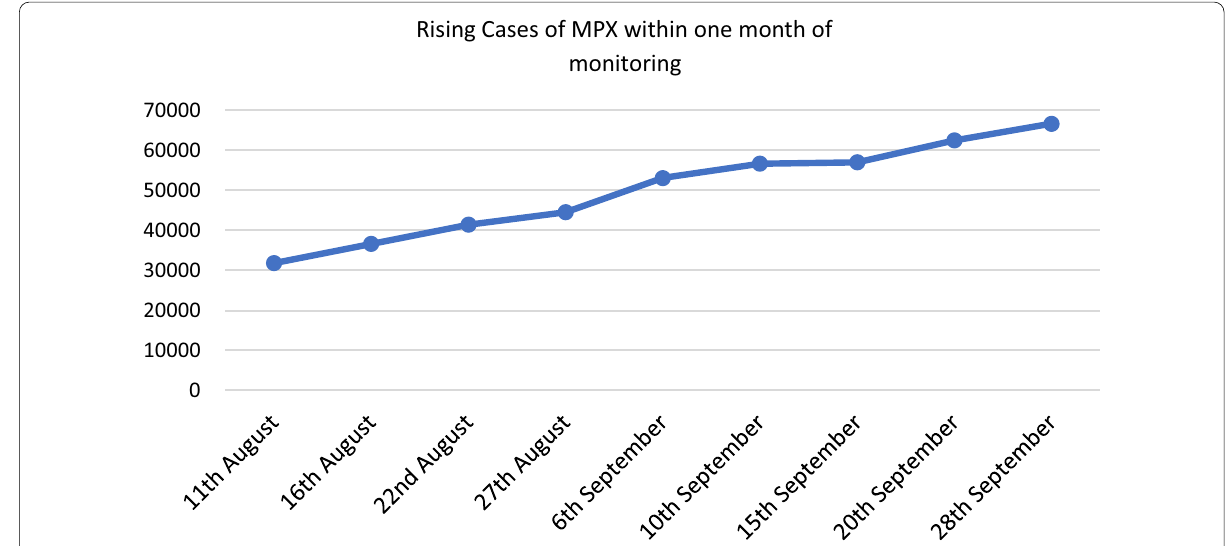
Fig. 2 Rising cases of monkeypox within 1 month of